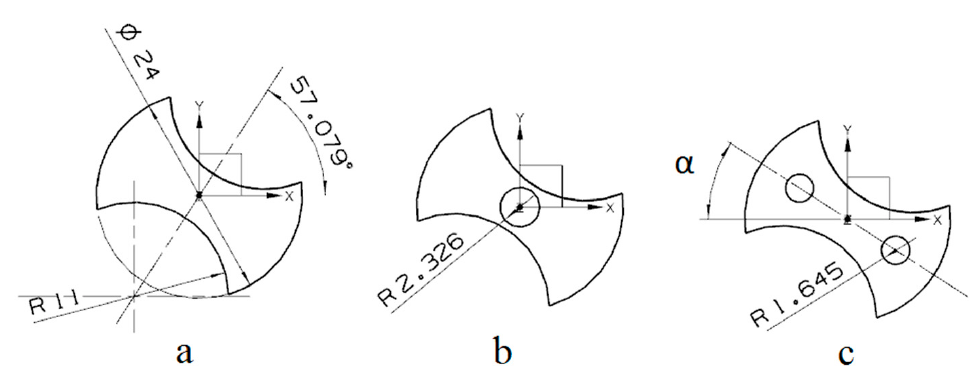
Figure 2. Typical drill cross-sections: ( a ) solid drill ( b ) with a single coolant channel ( c ) with two coolant channels. Drills with coolant channels have total hole areas equal to 17 mm 2 . (Length parameters are in mm.).